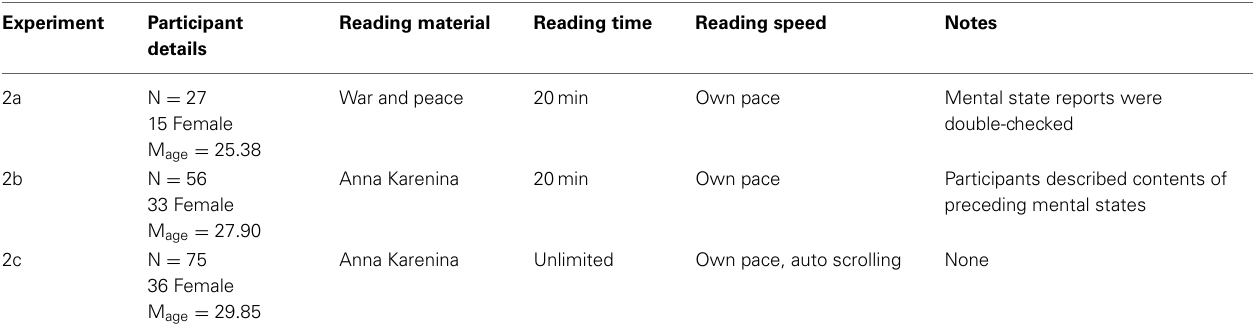
Table 2 | Experimental design of Experiments 2a, 2b, and